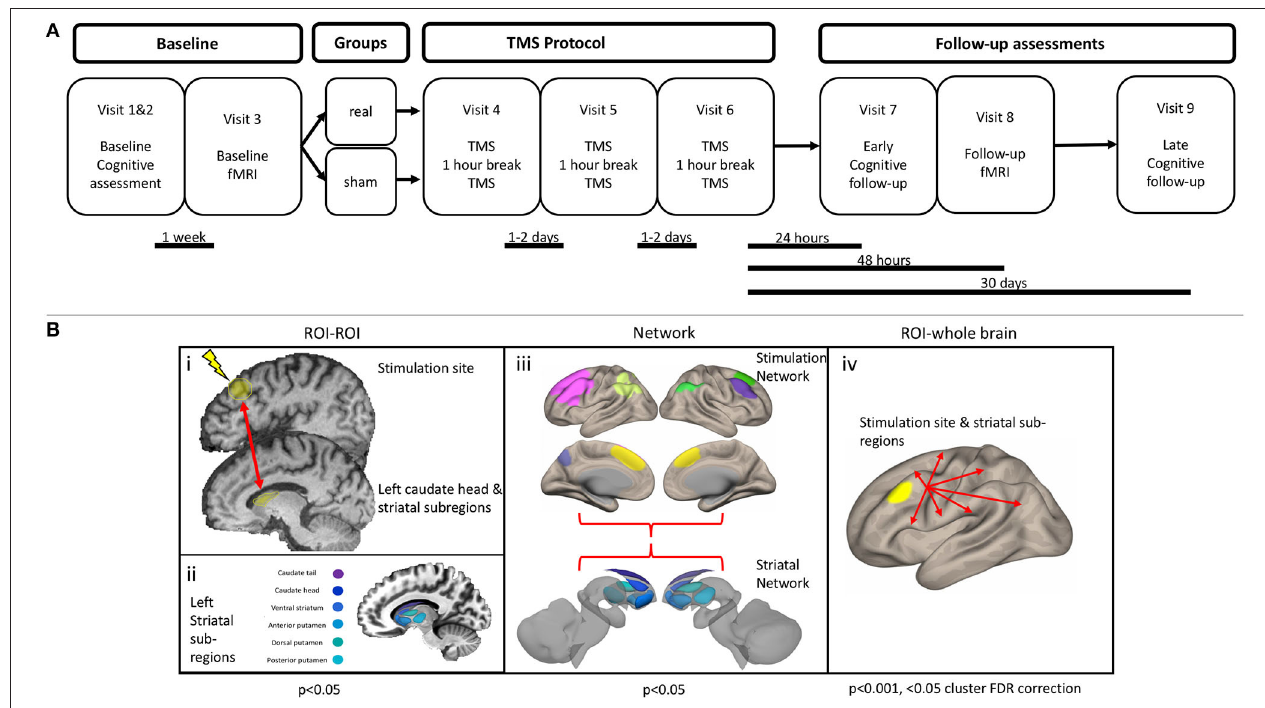
FIGURE 2 | (A) Study protocol. (B) Functional connectivity analysis outline. (i) Region of interest (ROI) to ROI analysis. An ROI–ROI analysis was performed, specifically assessing the connectivity between the stimulation site and the left caudate head, along with five other striatal subregions. (ii) Left striatal subregions were obtained from a functional parcellation of the striatum ( 28). (iii) Connectivity within and between the striatal network and stimulation network was assessed. Striatal network consisted of the six subregions of the left striatum. Stimulation network consisted of seven cortical ROIs, which display strong functional connectivity with the stimulation site. (iv) An ROI–whole brain analysis was performed with the stimulation site and each of the six left striatal